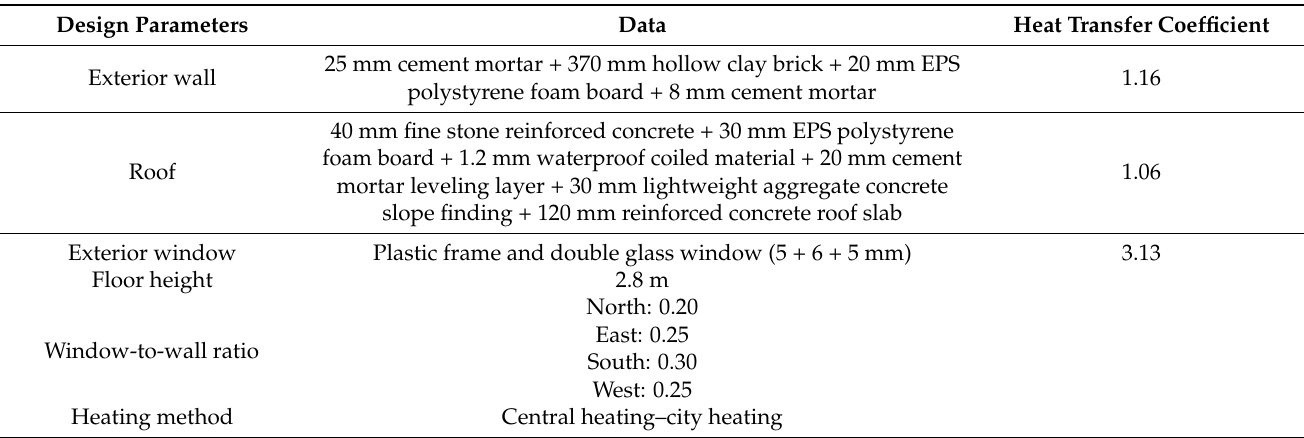
Table 1. Original design parameters (OP).